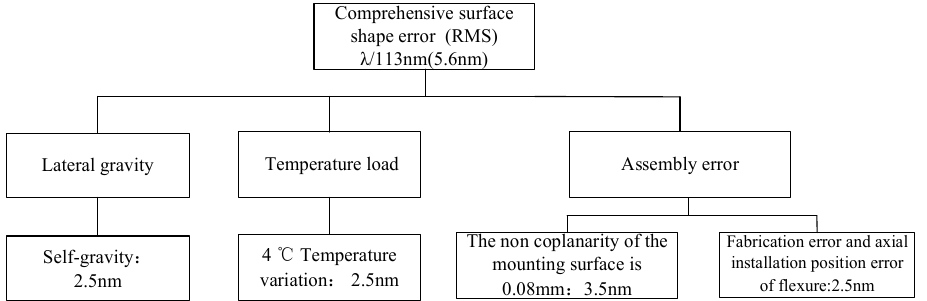
Figure 2. Schematically illustrates the performance metrics. A partially closed back monolithic, SiC mirror configuration is examined. The aperture is 1.3 × 1.2 m, the radius of curvature is 4.6998684 m, and the mass is 73 kg (the lightweight ratio relative to the solid mirror reaches 86.8%). The mirror is supported by three flexures through the supporting holes located on its back as shown in Figure 3a. The three Invar sleeves are bonded to the internal surface of supporting holes by using an epoxy adhesive (GHJ-01(Z)) in a 120-deg interval for improving thermal stability. The flexure is attached to sleeves and the back plate by screws, respectively. The mirror is fabricated with its optical axis vertical. As ground testing with the optical axes horizontal can result in less distortion than in the vertical orientation, the mirror is tested horizontally.